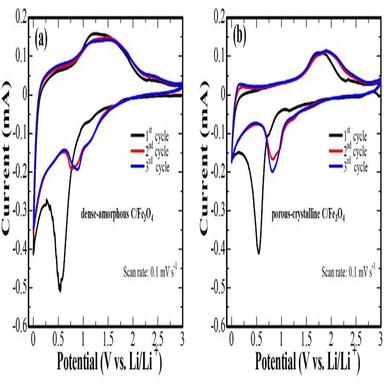
Cyclic voltammetry (CV) curves of the dense-amorphous (a) and porous-crystalline (b) C/Fe3O4 microspheres scanned in the potential window of 0–3 V at 0.1 mV s1 .